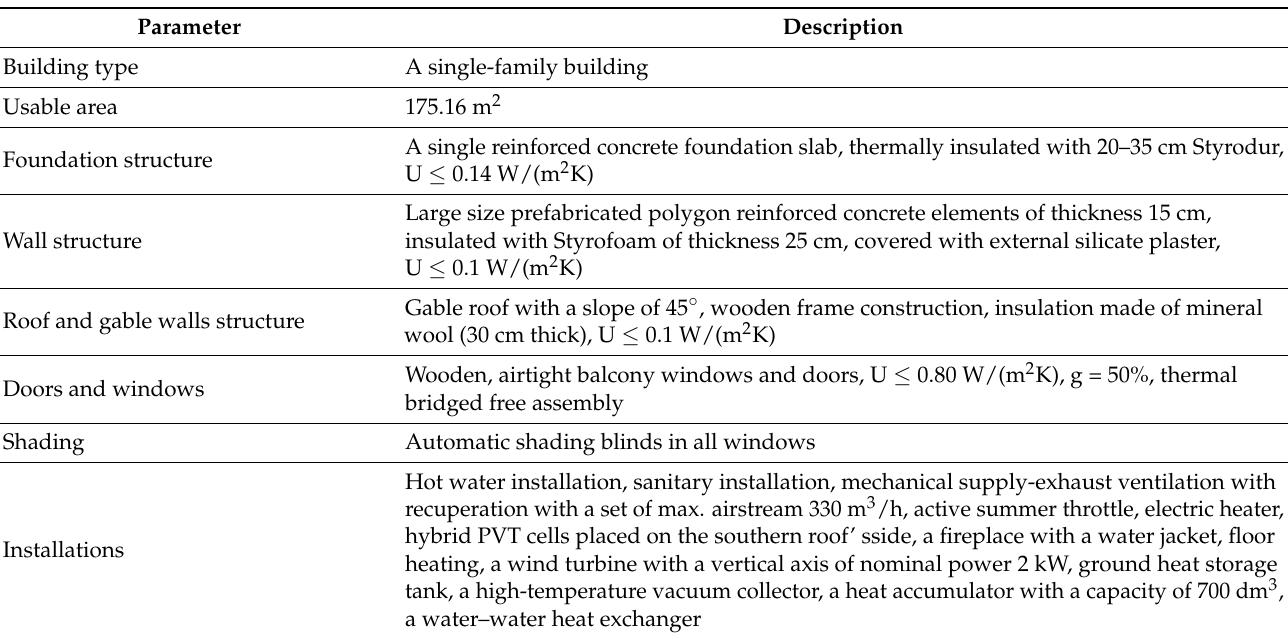
Table 6. The passive building